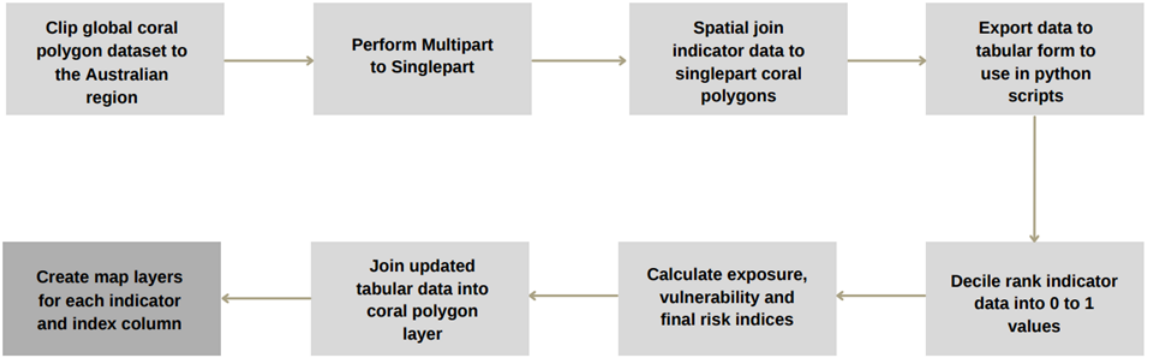
Figure 3. Outline of GIS and Python processes used to create a coral-mapped risk index from raw data.